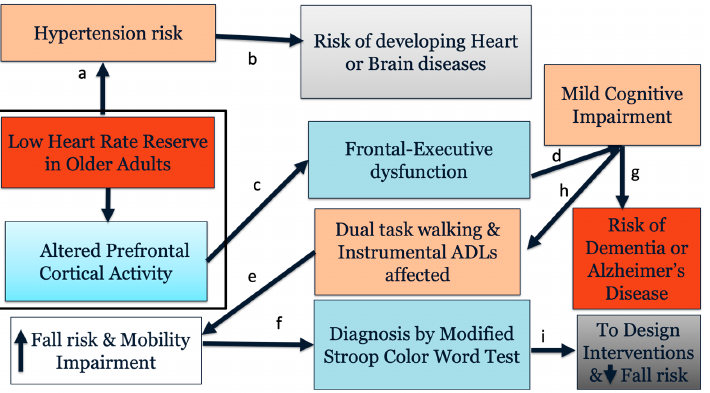
Figure 1. Conceptual model showing relationship between heart rate reserve and cognitive function in older adults. Box indicates associations examined by this study. Link a [7]; link b [3]; links c and e [13,25,26]; link d [27]; link f [24]; link g [28]; link h [29]; link i [30].